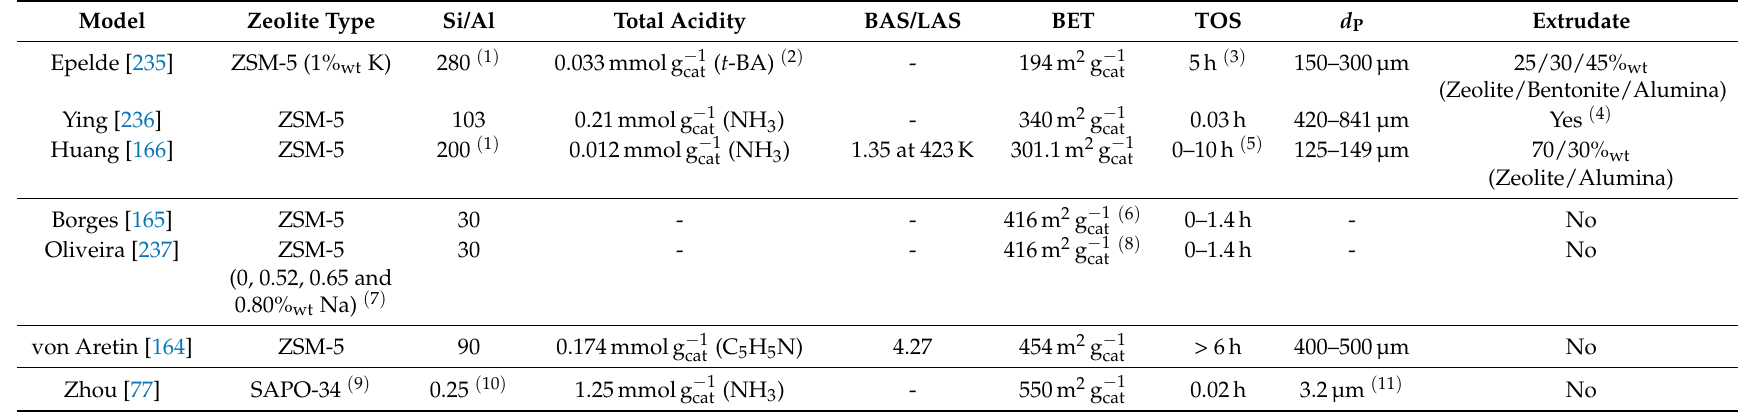
Table 1. Properties of the different catalysts which were used for the kinetic models of olefin cracking; besides the zeolite type, its silicon-to-aluminum ratio (Si/Al), its total number of acid sites plus determination method, its ratio of Brønsted to Lewis acid sites (BAS/LAS) and its surface area according to the method by Brunauer–Emmett–Teller (BET) are shown. Furthermore, the time-on-stream (TOS) after which the kinetic data were taken, the particle size ( d P ) and information about whether an extrudate or pure powder was used are presented. The line separates the different subsections. A hyphen represents missing information.